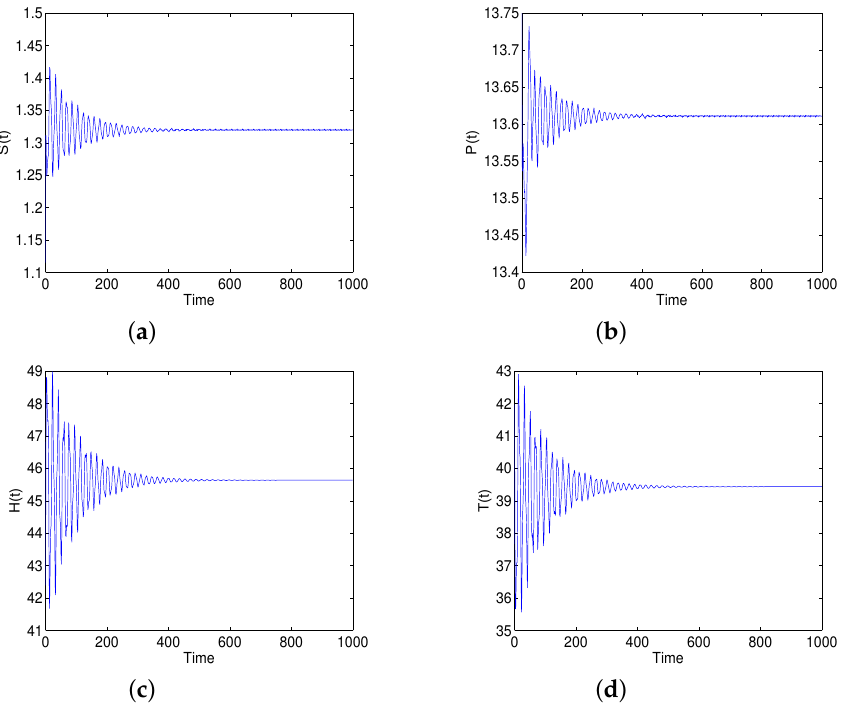
Figure 7. The time plot of ( a ) susceptible population, ( b ) psychological addicts, ( c ) physiological addicts and ( d ) drug-users in treatment for τ 2 = 8.2943 < τ 2 ∗ = 8.9875 and τ 1 = 1.5 ∈ ( 0, τ 10 ) with A = 2, d = 0.02, β 1 = 0.016, β 2 = 0.028, π = 0.03, γ = 0.095, θ = 0.5 and σ =